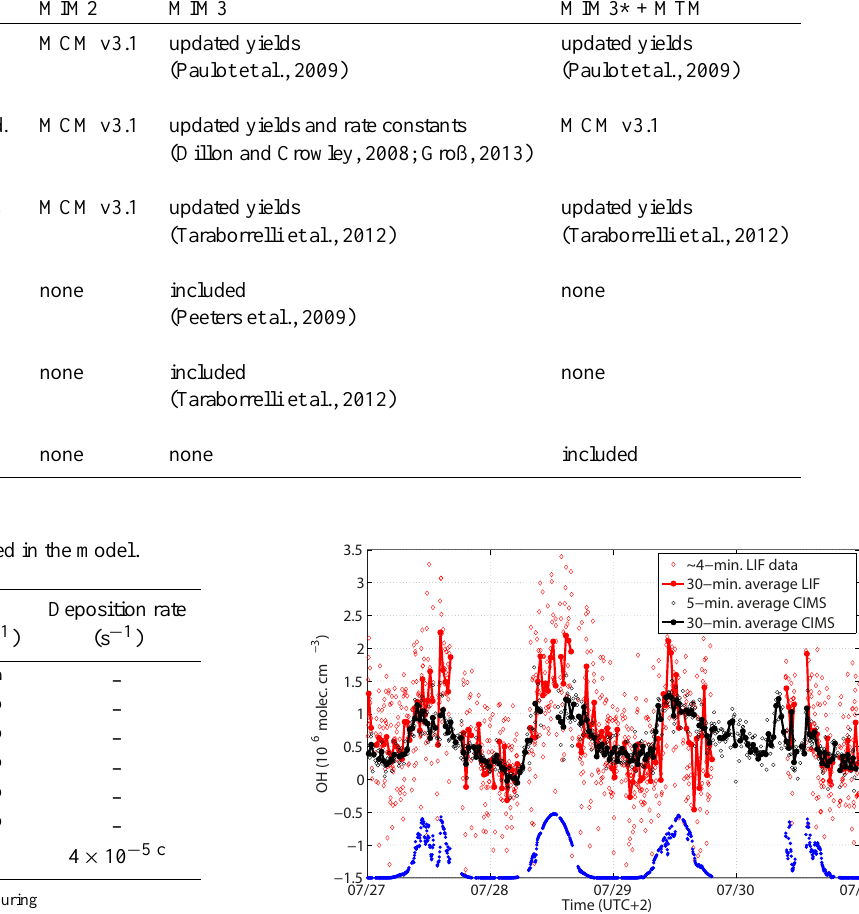
Table 2. Key differences between the chemical mechanisms used for the box model simulations. MIM2 MIM3 RO 2 + NO → RONO 2 MCM v3.1 updated yields updated yields (Paulot et al., 2009) (Paulot et al., 2009) RO 2 + HO 2 → OH + prod . MCM v3.1 MCM v3.1